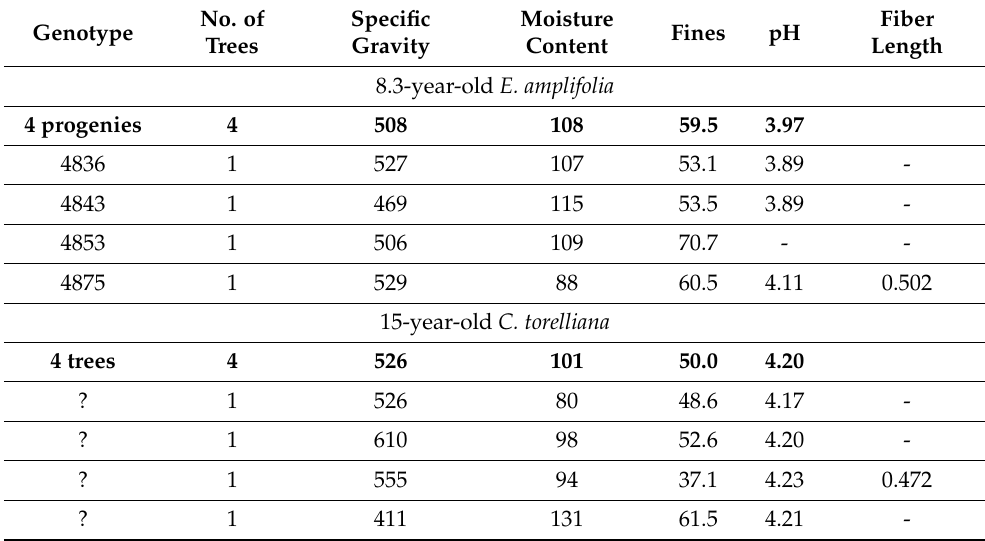
Table 5. Basal log specific gravity (kg/m 3 ), moisture content (%), batch fines (%), pH, and fiber length (mm) of Florida-grown E. amplifolia and C. torelliana adapted from [20]. Fiber No. of Specific Moisture Fines pH Genotype Length Trees Gravity Content 4 progenies